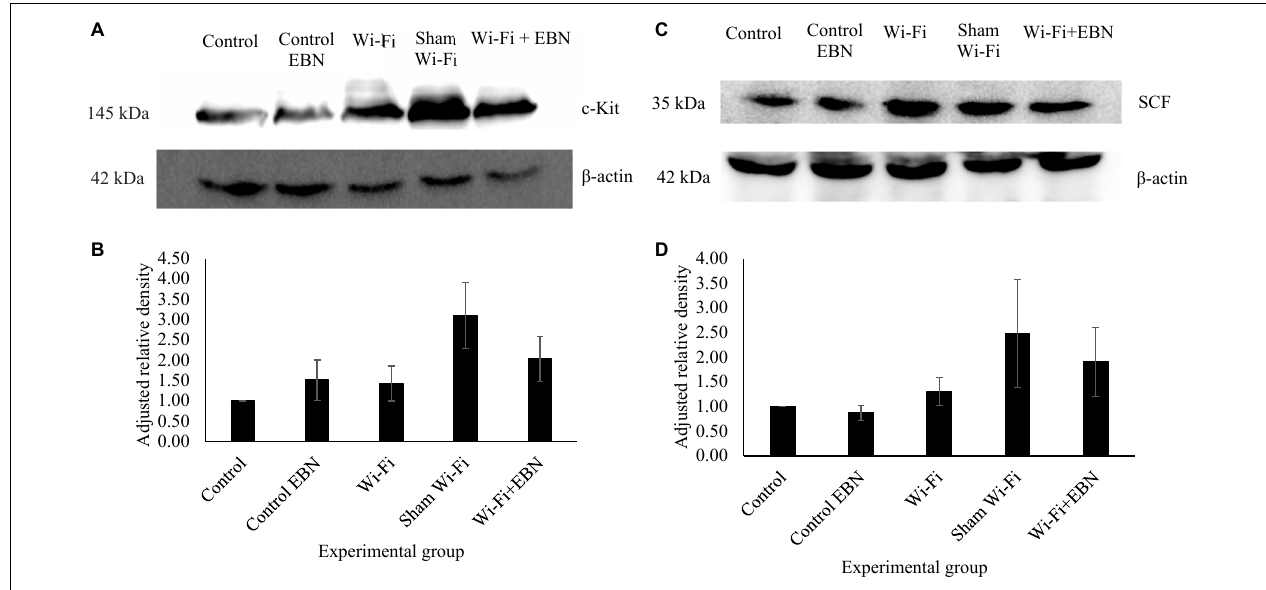
FIGURE 4 | Protein expression of c-Kit and SCF in each experimental group. (A,C) Are the representative blots of five different rats. The β -actin lanes belong to the same blot and have the same film exposure. (B,D) Represents relative intensities compared with β -actin measured by ImageJ. Data are expressed as mean ± SEM ( p > 0.05; One-way ANOVA, n = 5).